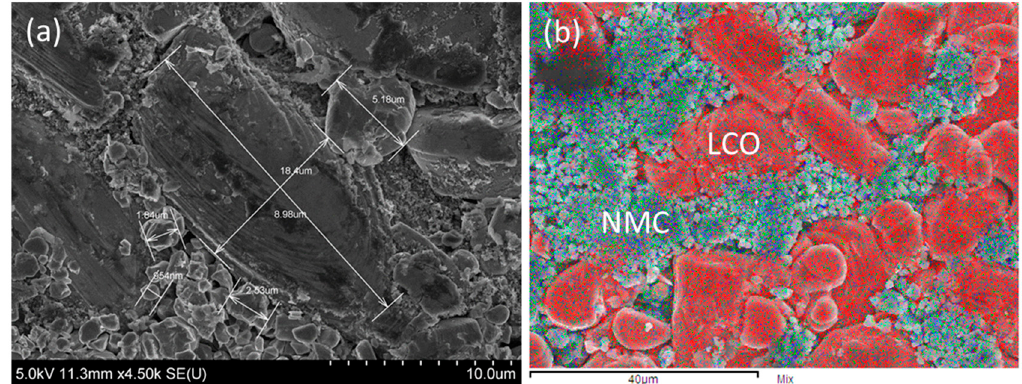
Figure 5. ( a ) Scanning electron microscopy (SEM) and ( b ) associated energy-dispersive X-ray spectroscopy (EDX) for the positive electrode (PE).